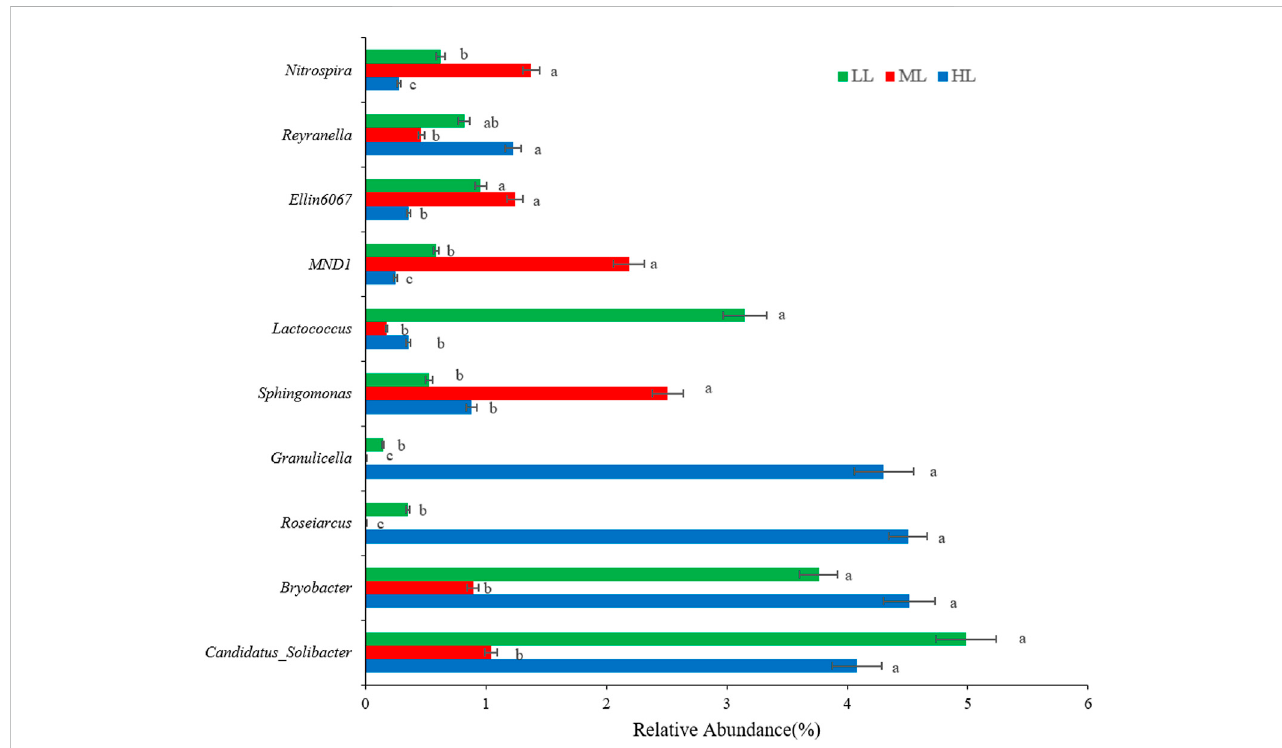
Genus-level composition of bacteria detected in the forest soil at different latitudes. Different lowercase letters indicate signi fi cant differences at the p < 0.05 level among the treatments. LL, low-latitude; ML, mid-latitude; HL,